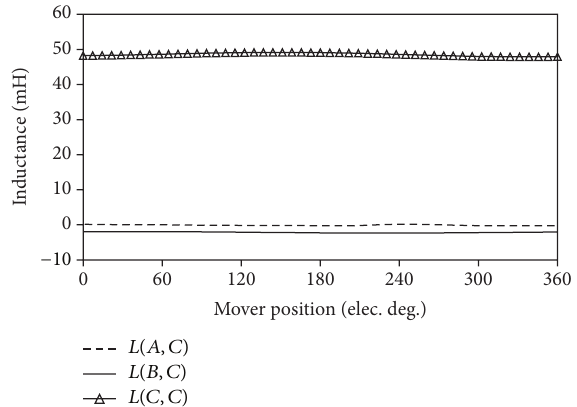
Figure 14: Comparison of